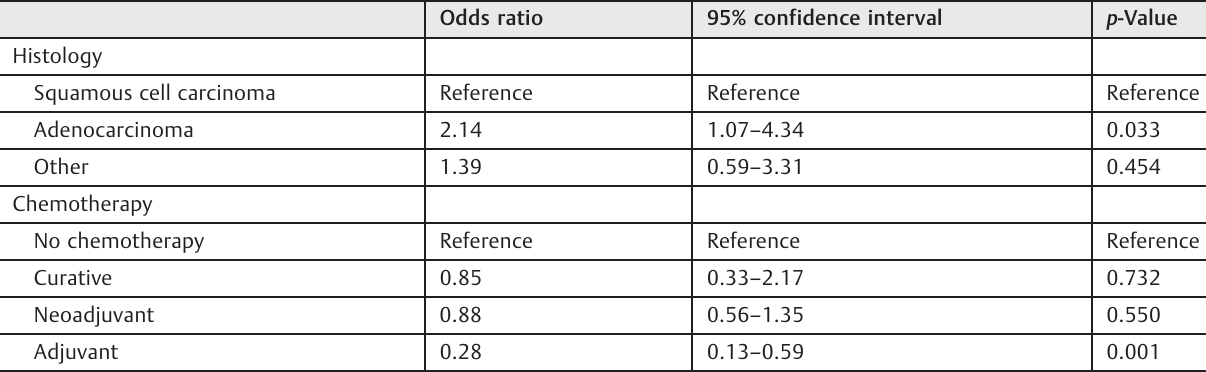
TH Open Vol. 6 No. 3/2022 © 2022. The